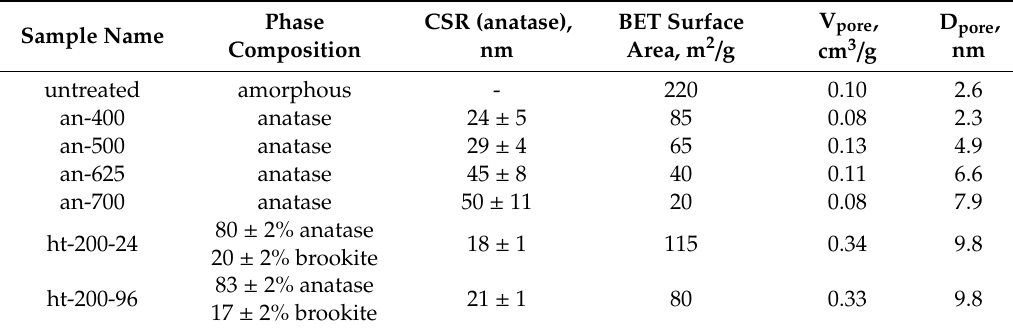
Table 1. Phase composition, anatase coherent scattering region size (CSR), Brunauer–Emmett–Teller (BET) specific surface area, pore volume (Barrett–Joyner–Halenda, or BJH model), and average pore diameter of the obtained samples.